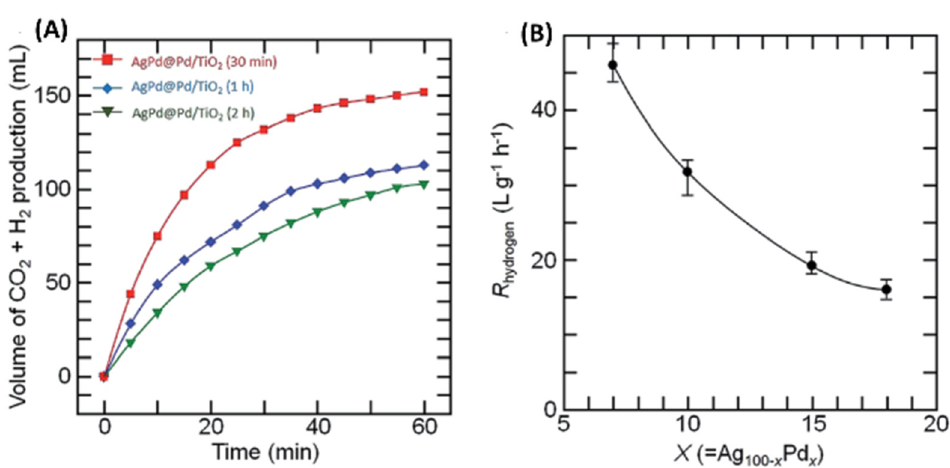
Figure 17. ( A ) Gas generation by formic acid decomposition (20 mL, 0.25 M) vs. time (min) for various PdAg-Pd core-shell catalysts on TiO 2 samples; ( B ) variation rate in H 2 generation for Pd x Ag (100- x ) at 27 °C. Adapted with permission from the American Chemical Society. Copyright 2015 American Chemical Society.